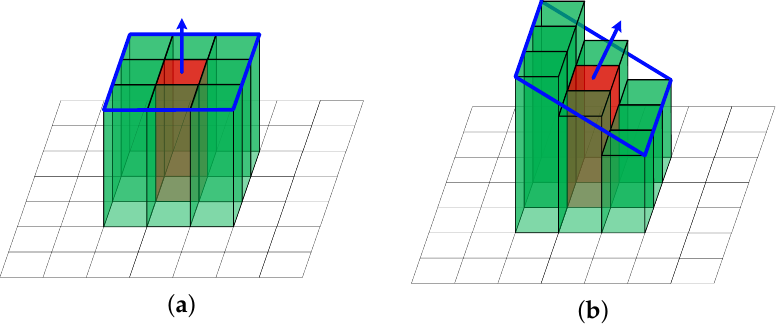
Figure 4. ( a ) Plane composed of the seed cell at the center and eight neighbor cells with unknown elevation. The normal of the plane in ( a ) is ( 0,0, 1 ) T . ( b ) Example of a plane whose normal has been randomly changed. The seed cell at the center is fixed, and the elevation of other cells vary with the plane.